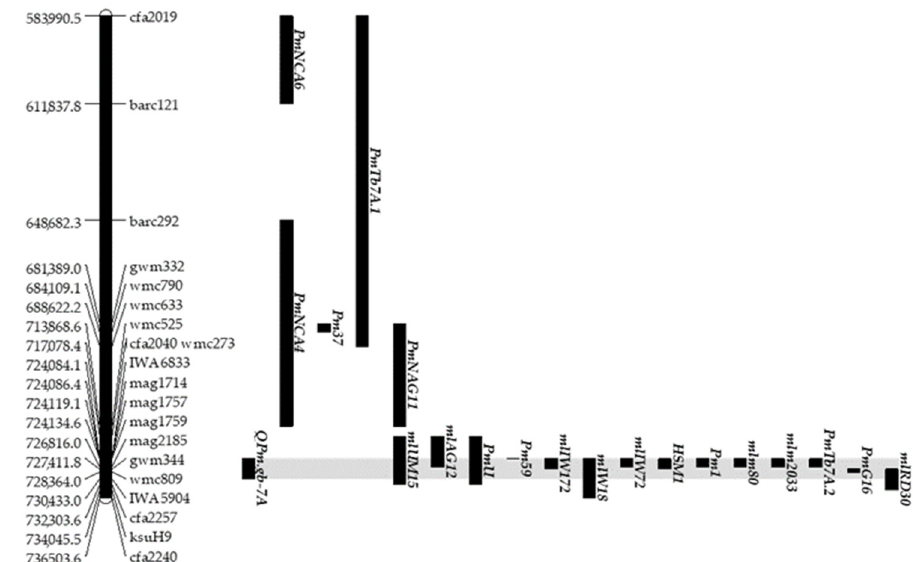
Figure 2. Physical map of Q Pm. gb-7A and other regions harboring significant effects for powdery mildew resistance. The physical position, expressed in kilobases, and the flanking molecular markers of each QTL are reported.